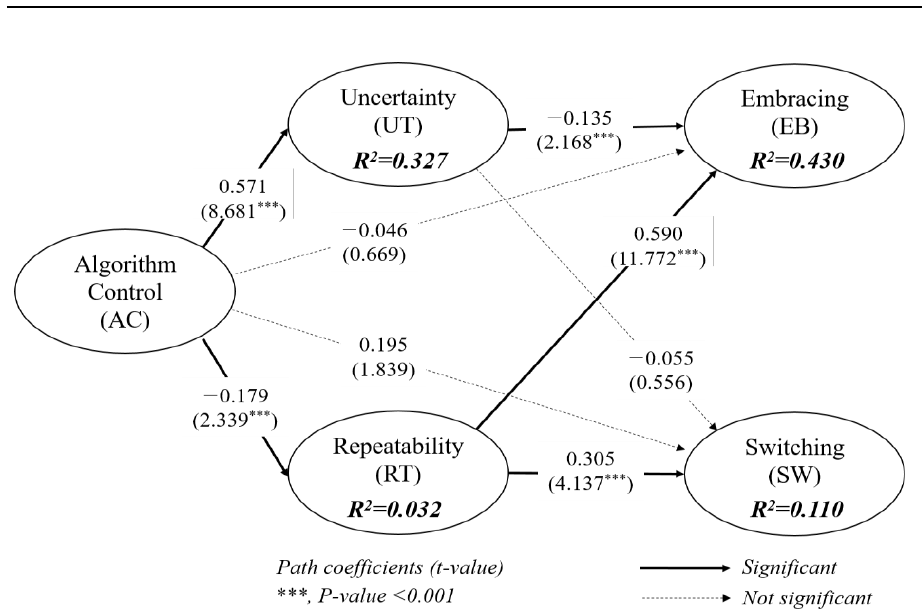
Figure 2. Results of Testing the Hypotheses. *** means p-value